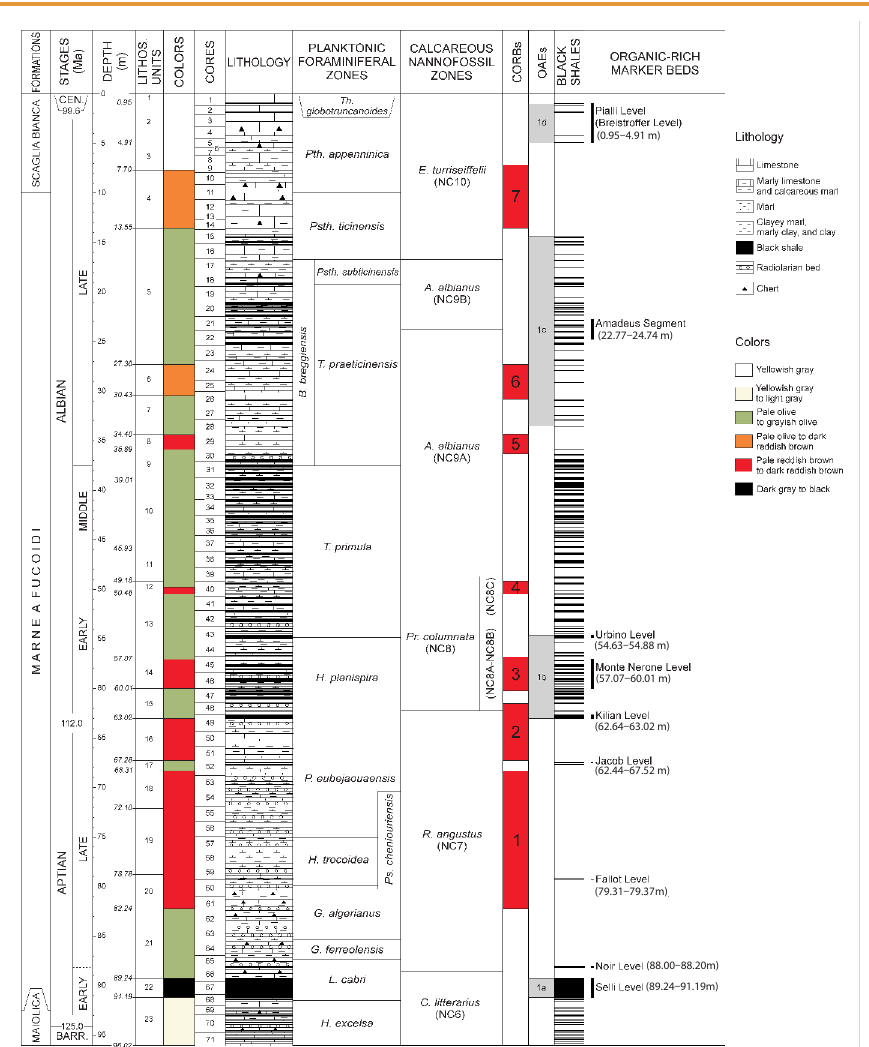
Figure 2. Stratigraphic framework of the Poggio le Guaine core with real stratigraphic depths according to bed dip measurements. Also shown are the occurrence and distribution of the organic-rich black shales including the marker beds resulting from Oceanic Anoxic Events (OAEs) and the discrete intervals where reddish colored beds become dominant (Cretaceous Oceanic Red Beds, CORBs). Integrated plankton biostratigraphy is adapted after Coccioni et al. (1987, 1989, 1990, 1992, 2007), Erba (1988, 1992), Tornaghi et al. (1989), Tiraboschi et al. (2009) and unpublished data. Abbreviations: Lithos.=Lithostratigraphic, Barr.=Barremian, Cen.=Cenomanian, H.= Hedbergella , L.= Leupoldina , G.= Globigerinelloides , P.= Paraticinella , Ps.= Pseudoplanomalina , T.= Ticinella , B.= Biticinella , Psth.= Pseudothalmanninella , Pth.= Parathalmanninella , Th.= Thalmanninella , C.= Chiastozygus , Pa.= Parhabdolithus , N.= Nannoconus , Pr.= Predicosphaera , A.= Axopodorhabdus , R.= Rhagodiscus , E.= Eiffellithus . Timescale is after Ogg et al. (2008). Following Huber and Leckie (2011), the Aptian-Albian boundary is placed at the highest occurrence of Paraticinella eubejaouaensis